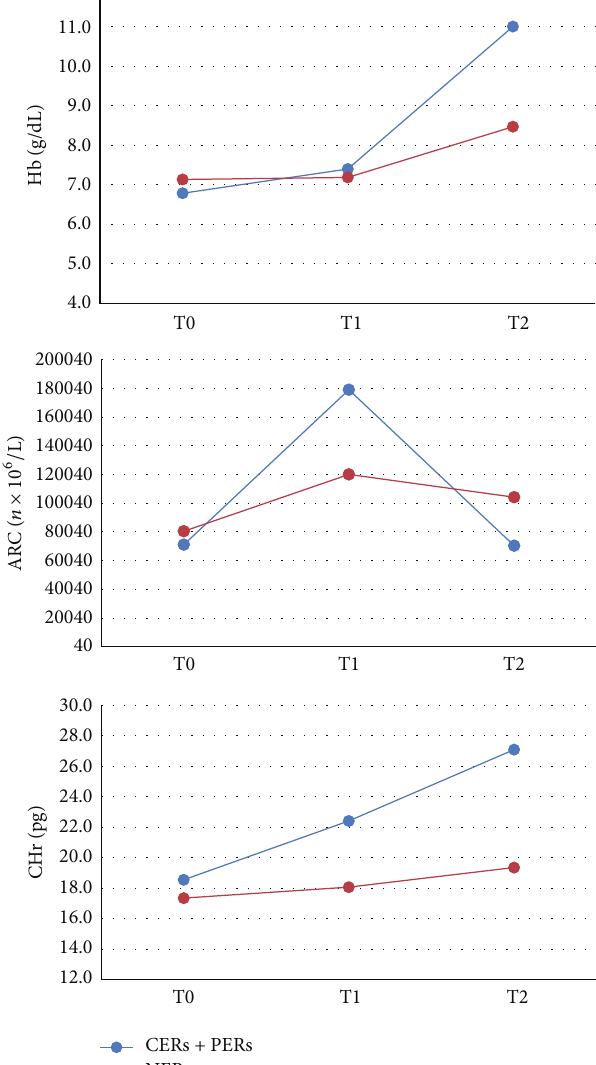
Table 1: Patients’ characteristics at diagnosis.